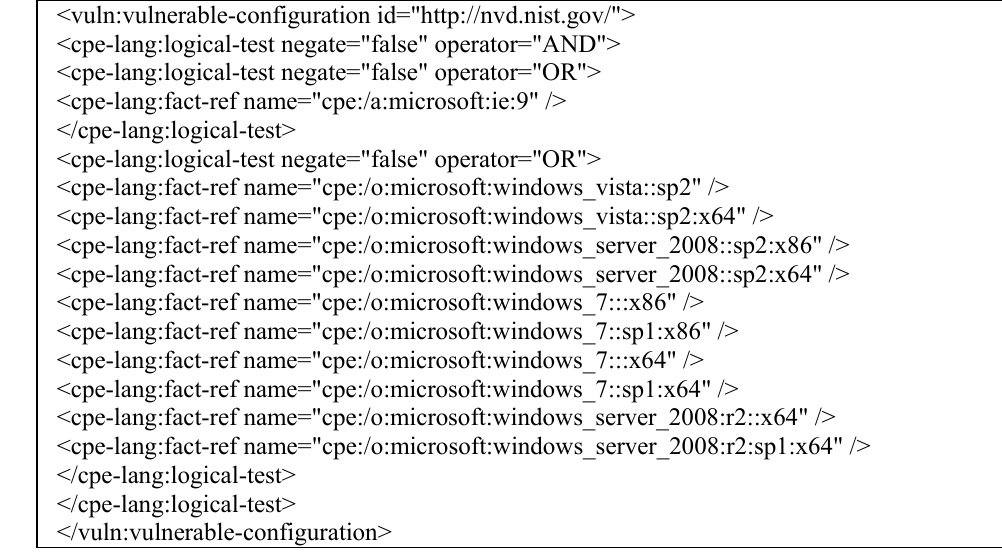
Figure 2. Example of vulnerability description represented by Common Vulnerabilities and Exposures (CVE).